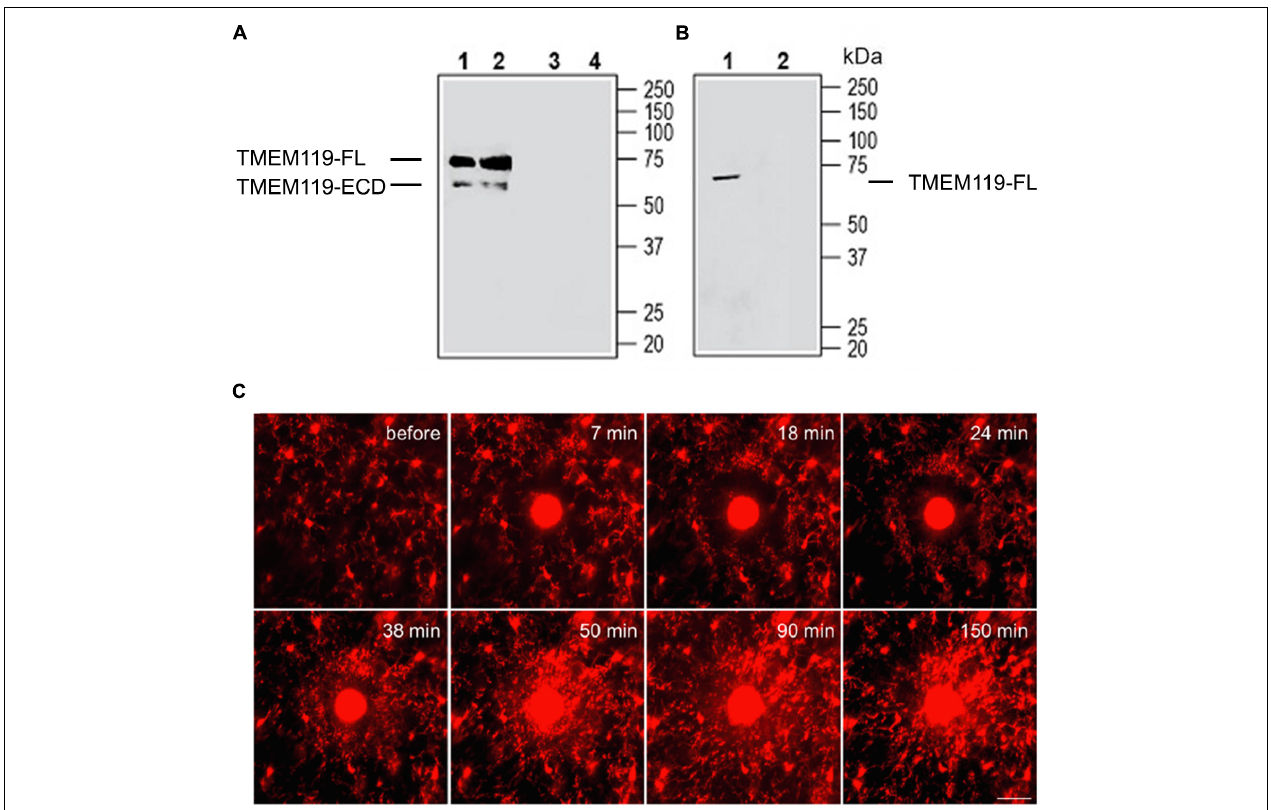
FIGURE 1 | Validation of anti-TMEM119 antibodies by Western blot and two-photon live imaging of TMEM119-tdTomato + microglia in vivo after laser-mediated injury. (A) Western blot analysis of mouse brain membranes (Lanes 1 and 3) and rat brain membranes (Lanes 2 and 4): 1, 2. Anti-TMEM119 (extracellular) antibody (#ANR-175), (1:200); 3, 4. An anti-TMEM119 (extracellular) antibody, preincubated with TMEM119 (extracellular) blocking peptide (#BLP-NR175). (B) Western blot analysis of mouse BV-2 microglia cell lysate: 1. An anti-TMEM119 (extracellular) antibody (#ANR-175), (1:200); 2. An anti-TMEM119 (extracellular) antibody, preincubated with TMEM119 (extracellular) blocking peptide (#BLP-NR175). FL, full length; ECD, extracellular domain. Data are cited from https://www.alomone.com/p/anti-tmem119-extracellular-antibody/ANR-175 with permission of the company. (C) After localized ablation inside the primary sensory cortex, neighboring TMEM119-tdTomato + microglia respond quickly with extended processes and bulbous termini. Time-lapse images show that microglia formed a spherical containment around the laser lesion site. Scale bar, 30 µ m. The red color indicates the mix of TMEM119-FL-tdTomato and TMEM119-ICD-tdTomato microglia. FL, full length; ICD, intracellular domain. Data are cited from Ruan et al. (2020) Brain Behav